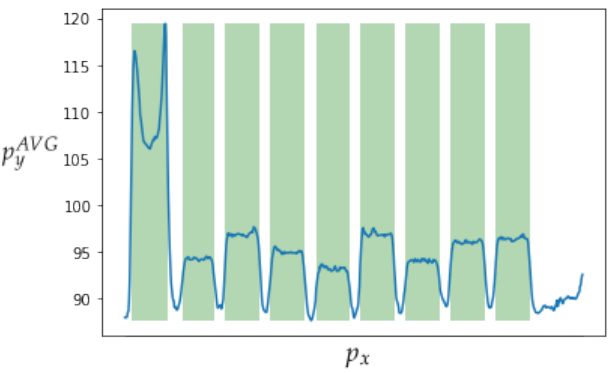
Figure 16. Detection of bands in an electrophoresis sample where p AVG y is the average value of p y and p x is the horizontal value of the pixel.